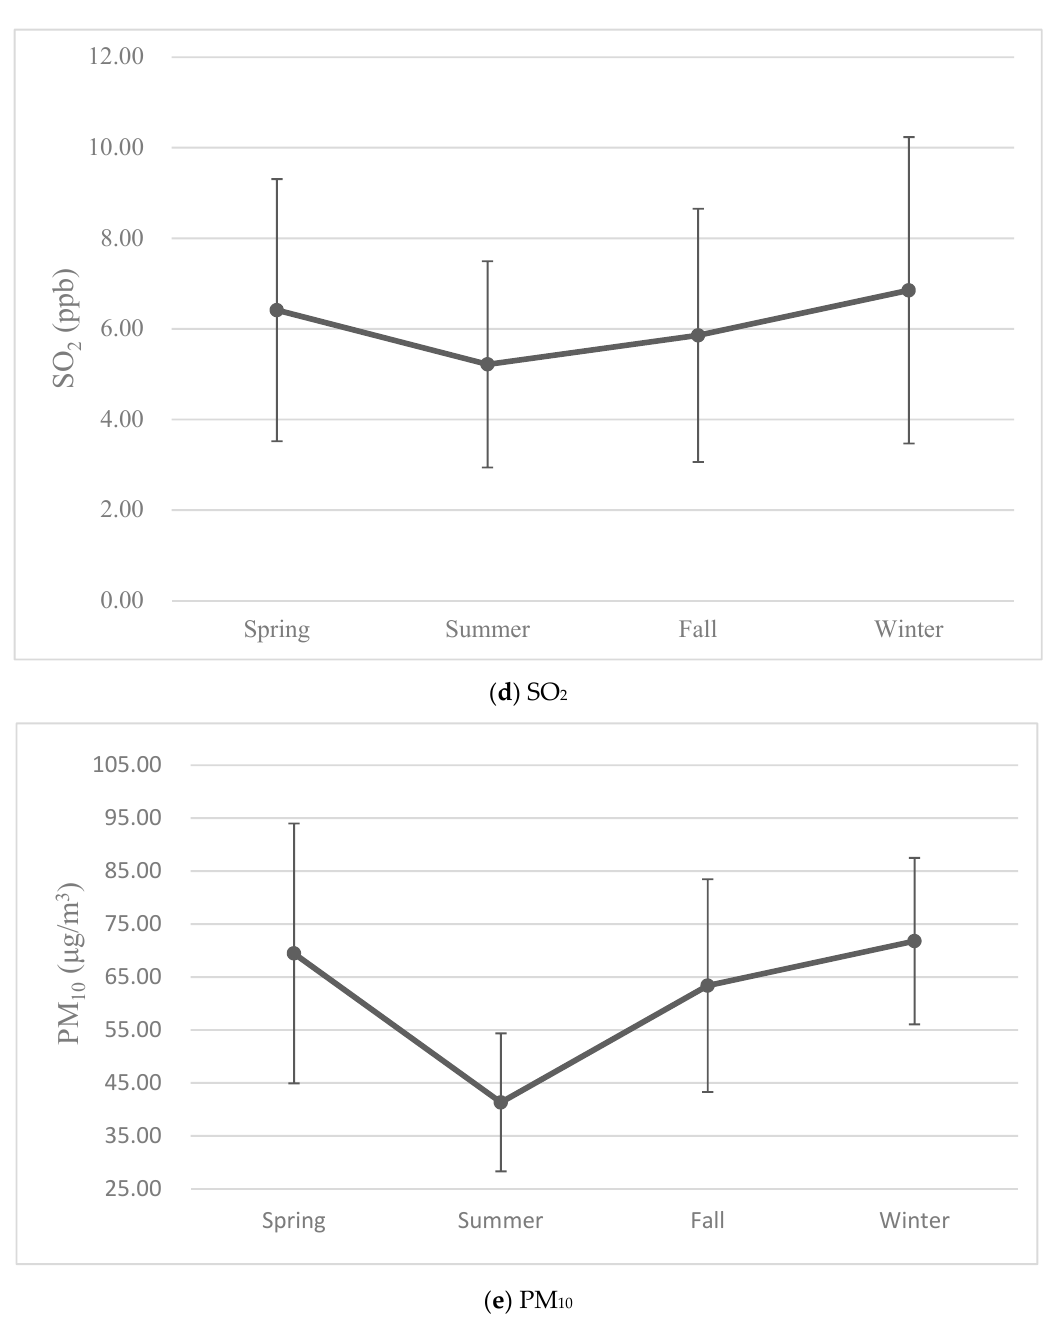
Figure 4. The seasonal variations of air pollutant levels over the years of birth of the study cohort. The data were presented as means with error bars indicating the range of ±1 standard deviation.